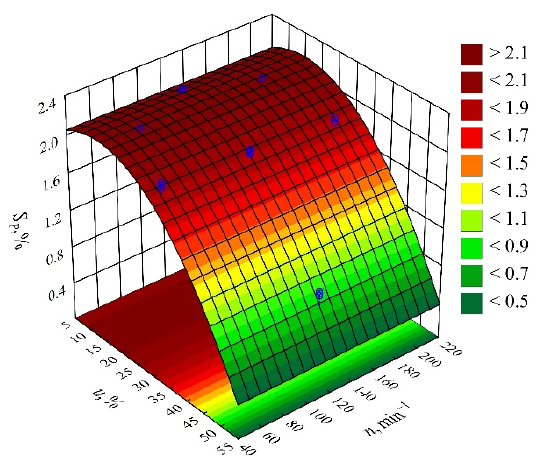
Figure 5. Response surface graph for the transverse shrinkage S T versus wheat bran content u and screw speed n.